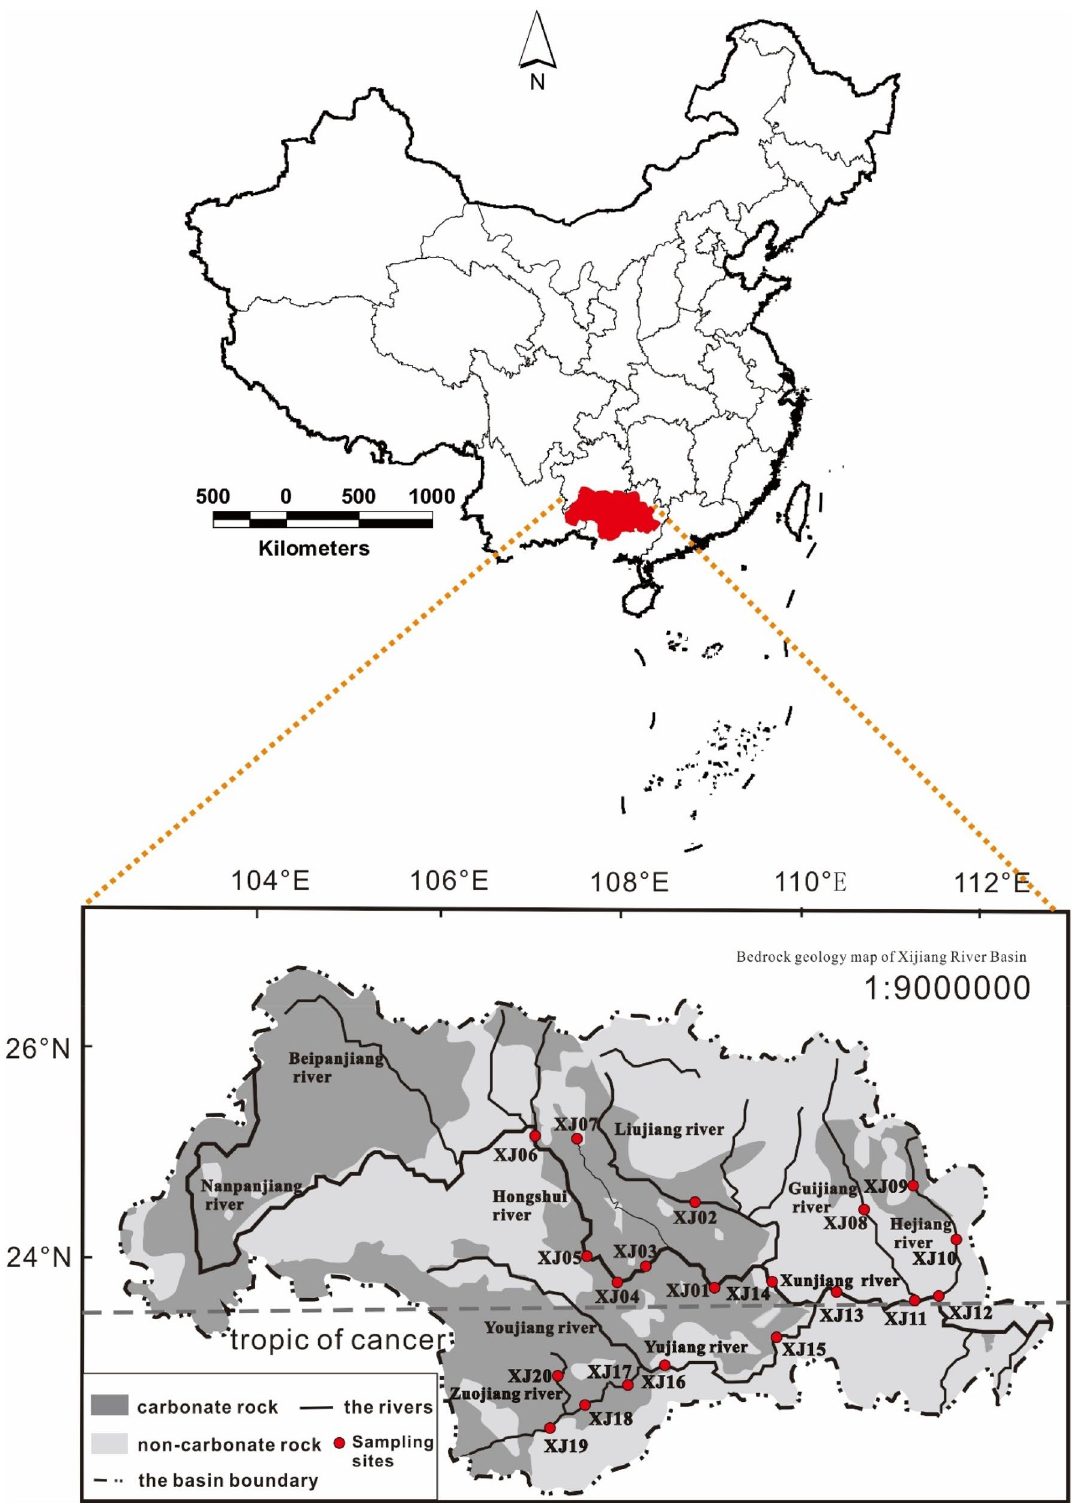
Figure 1. The hydrogeology and sampling point distribution in the Xijiang River Basin (this figure updated from Yu et al. 38